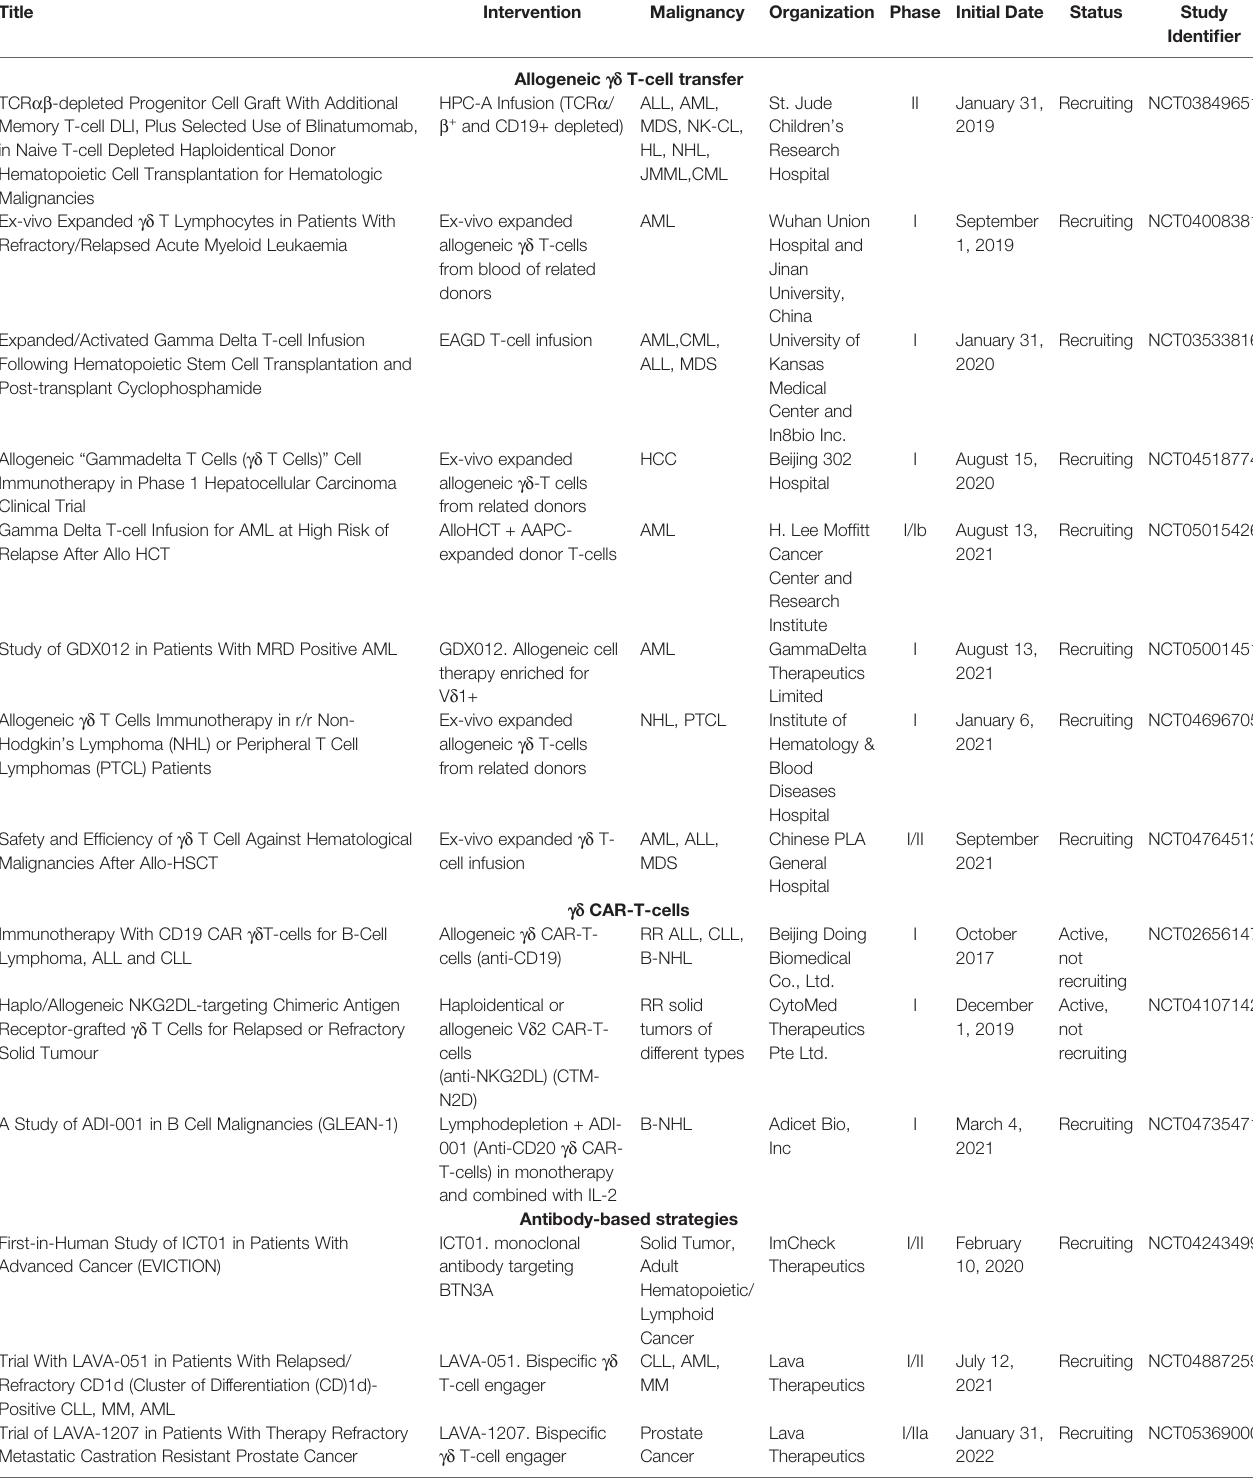
TABLE 1 | Ongoing clinical trials based on gd